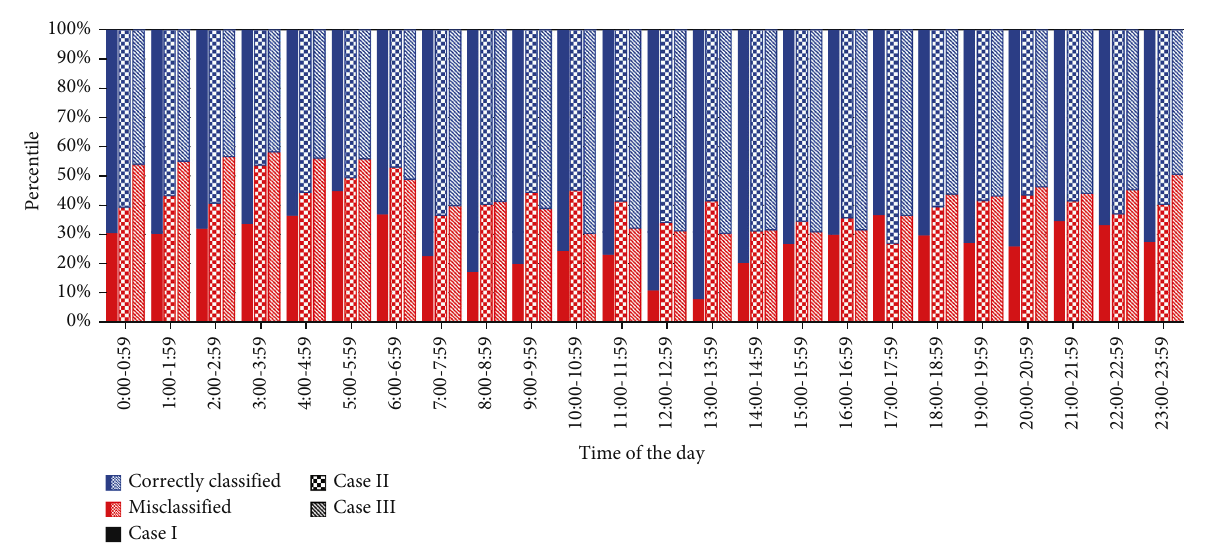
Figure 5: Correctly classi fi ed vs. misclassi fi ed improvement actions when conditioned on time of day for each case study